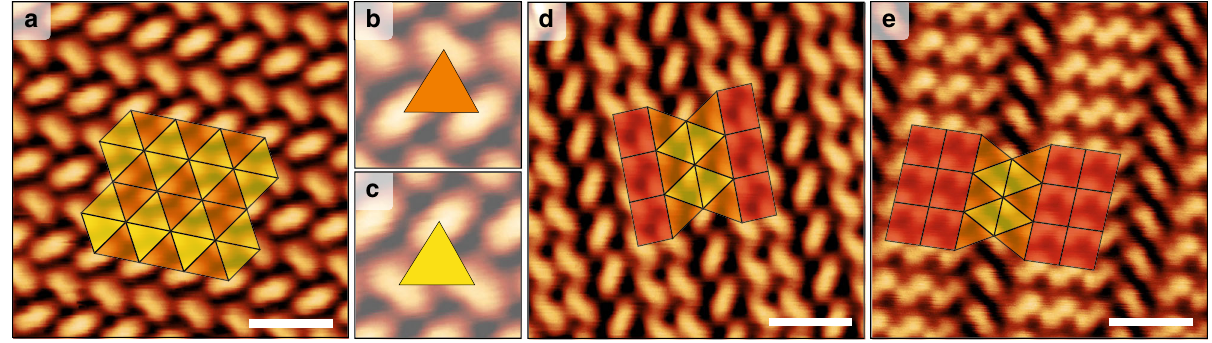
Fig. 3 Real space STM view of self-assembled molecular networks. These networks comprise BDA with distinct degree of carboxylation: pristine 2H- BDA, semi-carboxylated 1H-BDA and fully carboxylated 0H-BDA. a Regular tiling associated with a molecular phase comprising only 0H-BDA with tiling overlaid. b , c Detailed view of intermolecular binding motif associated with triangular tiles. d 2-uniform tiling realized by 2:1 mixture of 1H- and 0H-BDA. e 3-uniform tiling realized by 1:2:1 mixture of 2H-, 1H-, and 0H-BDA. Scale bar 2 nm.